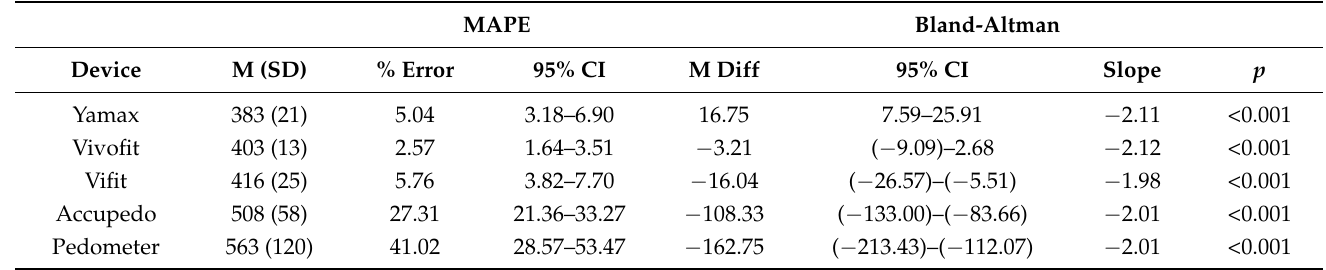
Table 2. Step count MAPE and Bland–Altman results for the lab-based semi-structured study